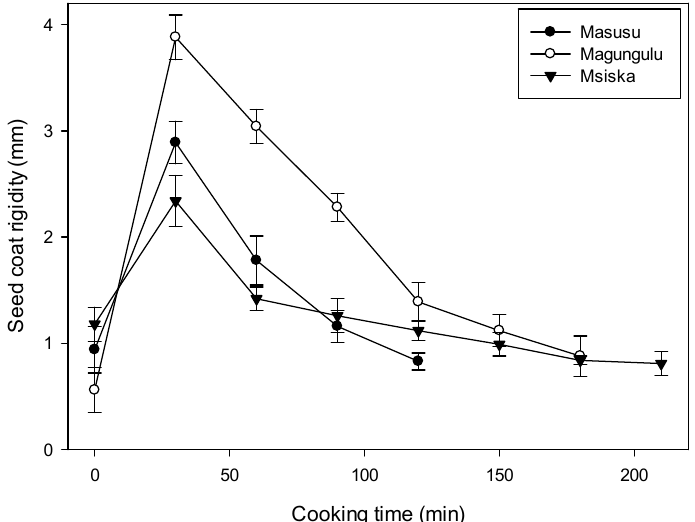
Figure 4. Variation of seed coat rigidity of common beans during cooking (ETC – Masusu, HTC - Msiska, Intermediate – Magungulu)